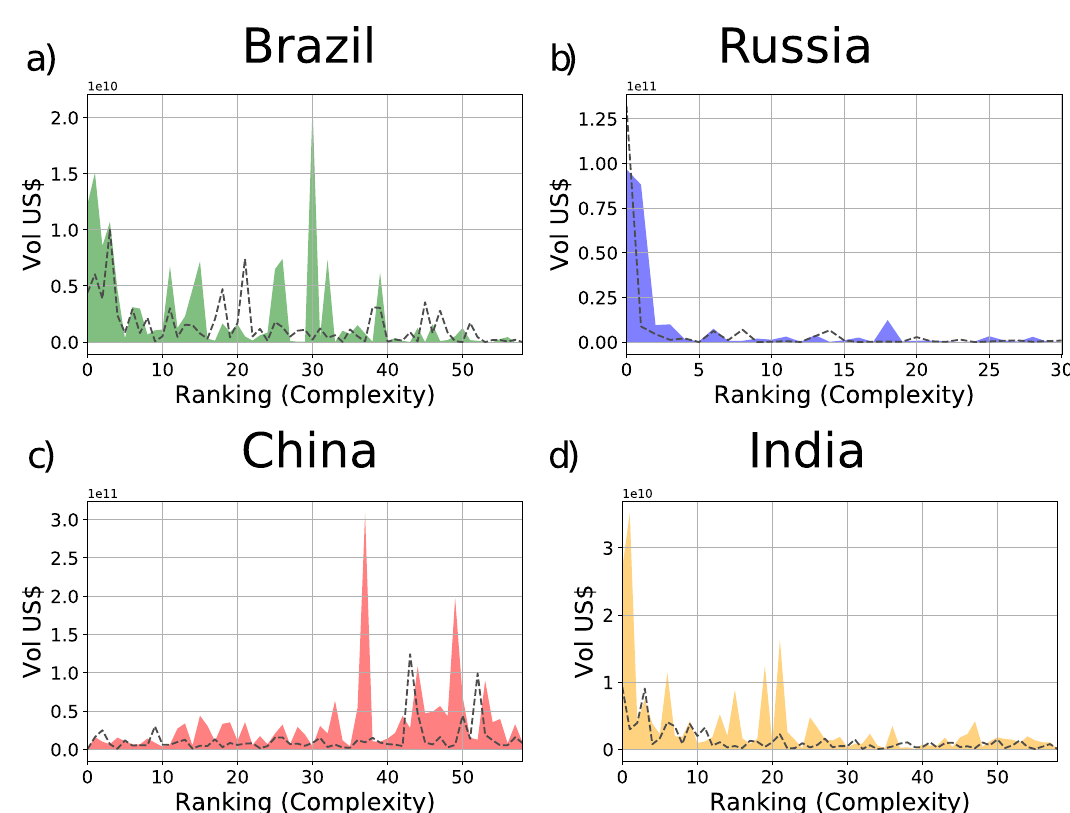
Fig 5. Products spectroscopy of the years 2005 (dotted lines) and 2015 (filled colors) of the countries: a) Brazil, b) Russia, c) China, and d) India. The figures show the export volume (in US Dollars) of those states for each product with M cp = 1 ordered in terms of their Complexity. The products have been grouped (10 for bin) and the export volumes of each product inside each bin have been summed.